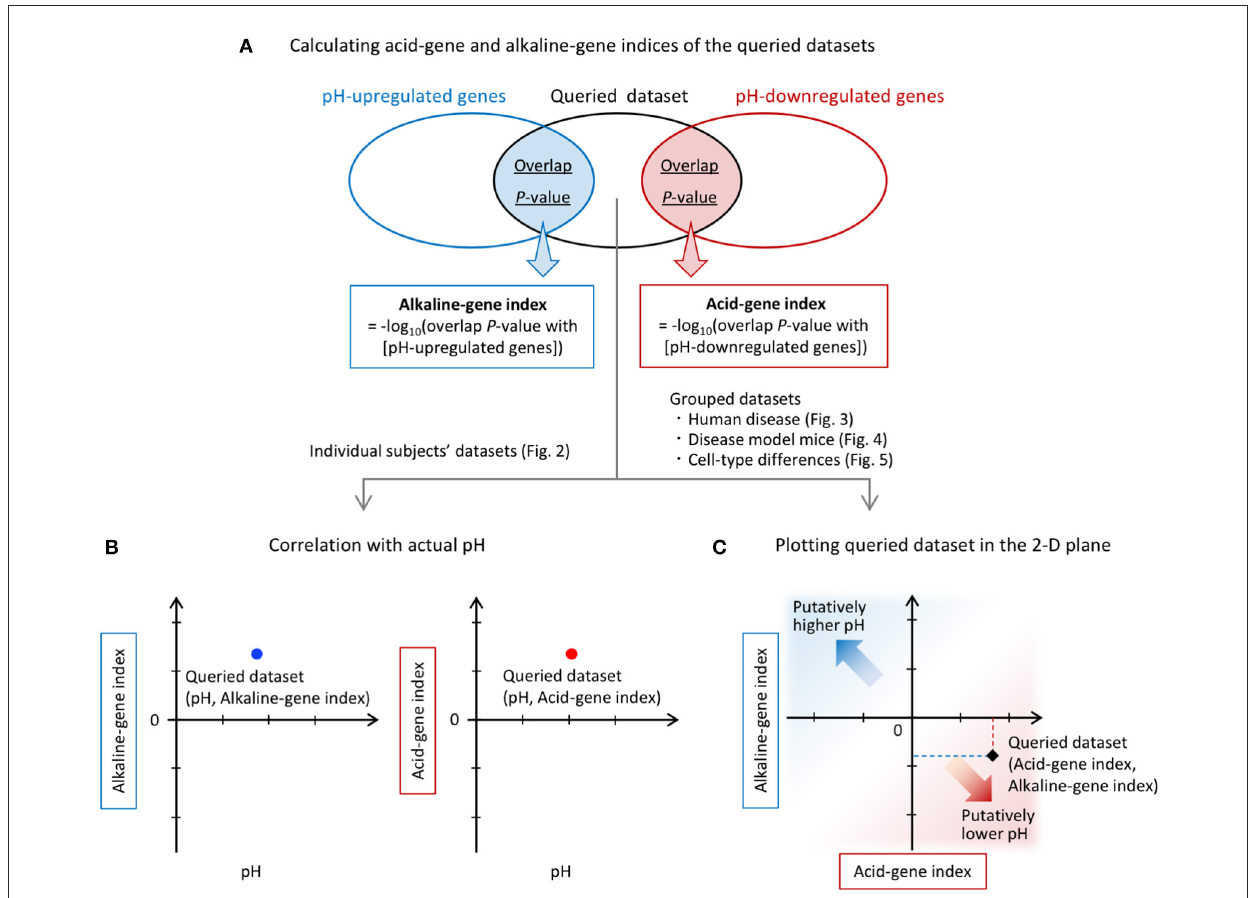
FIGURE1 Overview of the analysis. (A) Calculation of acid-gene and alkaline-gene indices of the queried datasets. pH-up/downregulated genes obtained from a previous study (60) were compared with each of the DEGs in the queried datasets. The overlap P -values were calculated for each comparison using the Running Fisher algorithm. The overlap P -values were transformed to alkaline-gene and acid-gene indices, respectively. (B) Individual subject datasets were used for correlation analysis with tissue pH. (C) The alkaline-gene and acid-gene indices were plotted in the two-dimensional (2-D) plane for each dataset in the analysis of grouped